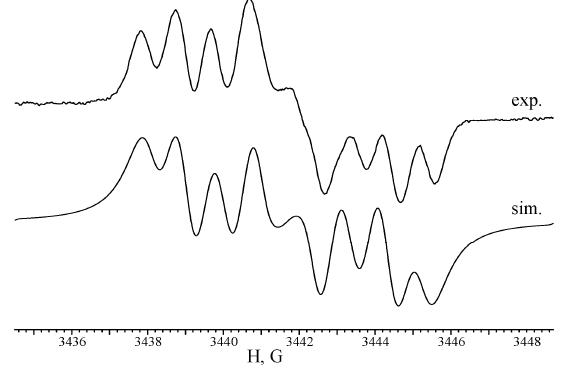
Figure 10. The X-band EPR spectrum of a mixture ” 1 +PbO 2 ”: exp.—the experimental spectrum (toluene, 298 K); sim.—its simulation (WinEPR SimFonia 1.25).